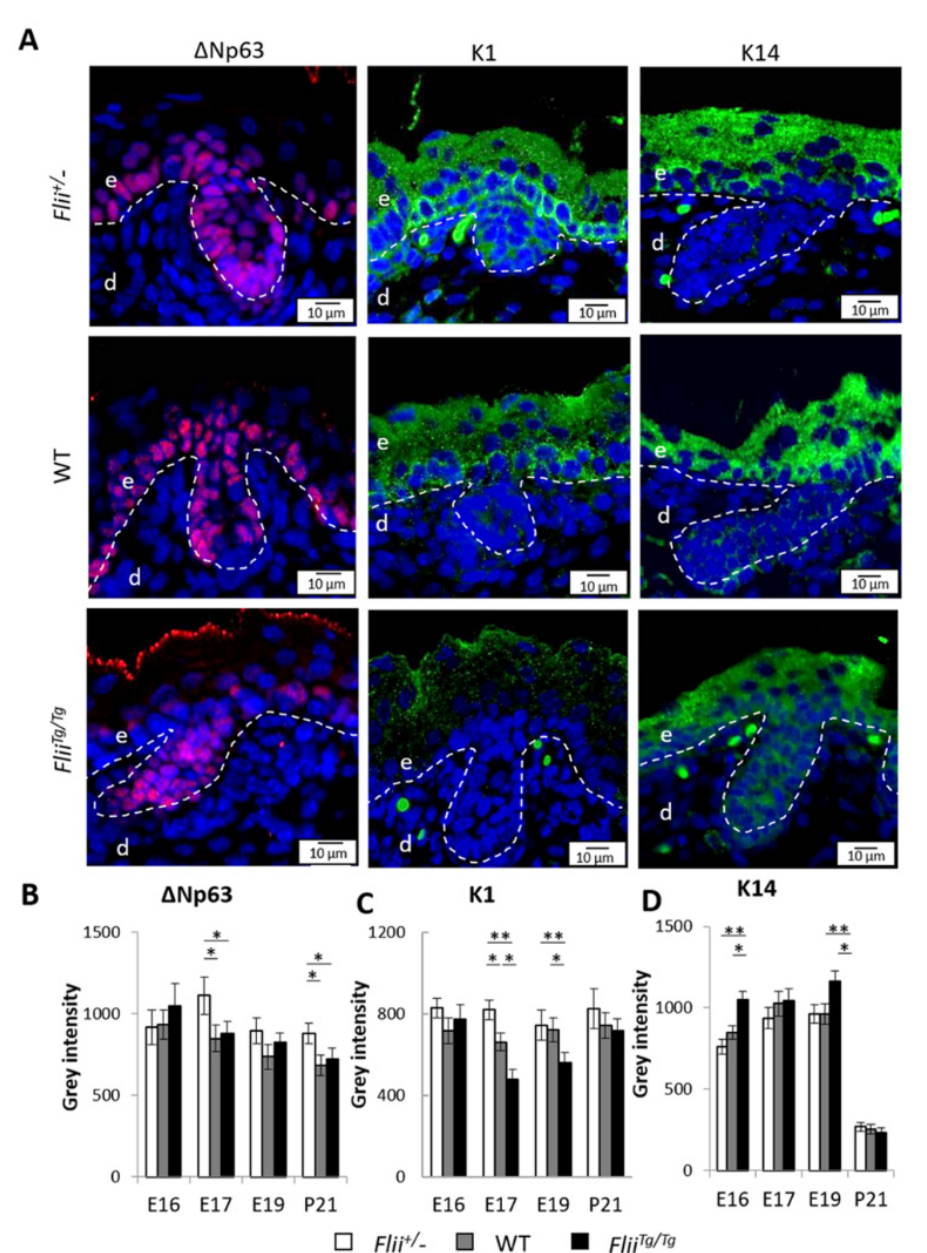
Figure 7. Flii deficiency results in increased differentiation potential in the epidermis during late embryonic development. ( A ) Immunofluorescence of ∆ Np63 and K1 in developing epidermis at E17 and K14 at E19. ∆ Np63 is shown as pseudo-stained red, K1 and K14 are shown as pseudo-stained green. Nuclear DAPI staining is shown as pseudo-stained blue. The epidermal-dermal junction is shown by white dash lines; e, epidermis; d, dermis. Scale bars, 10 μ m. Flii +/ − , Flii knockdown; WT, wild-type; Flii Tg / Tg , Flii overexpressing. Quantification of ( B ) ∆ Np63 expression ( C ) K1 expression and ( D ) K14 expression as grey intensity in the epidermis at E16, E17, E19 and P21. N = 6. Mean ± SEM. * p < 0.05. ** p < 0.005.